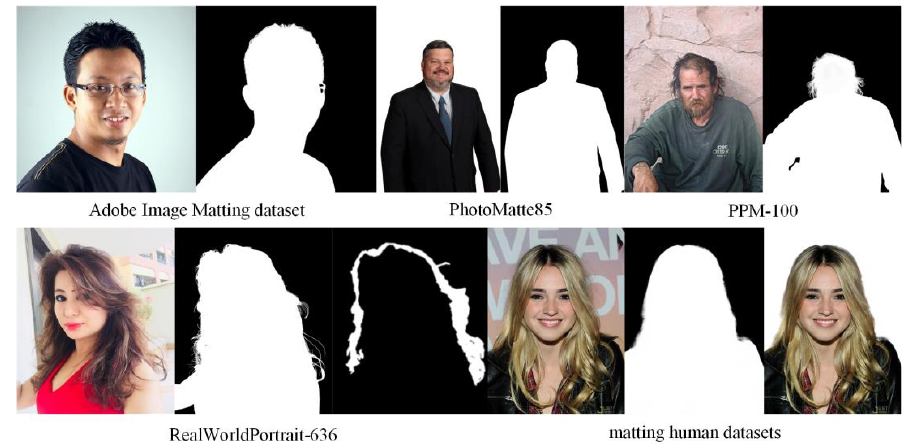
Figure 1. Comparison of the datasets.